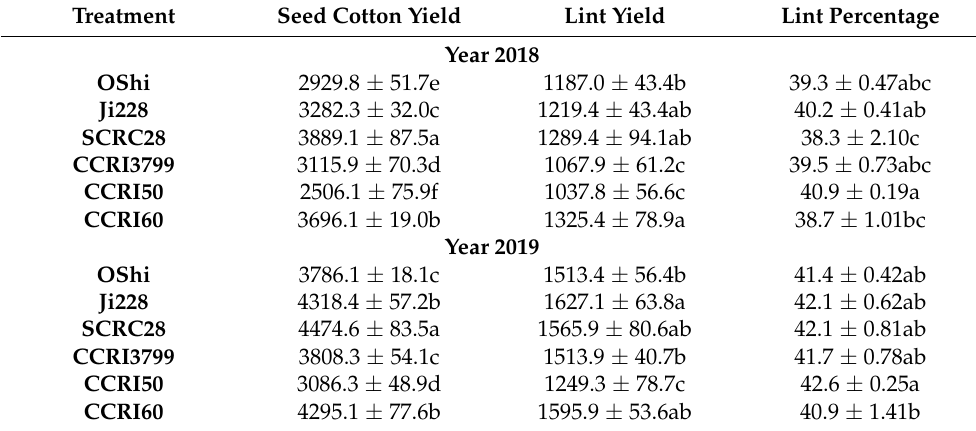
Table 5. Comparison of seed cotton and lint yields of various cotton varieties during the growing seasons in 2018 and